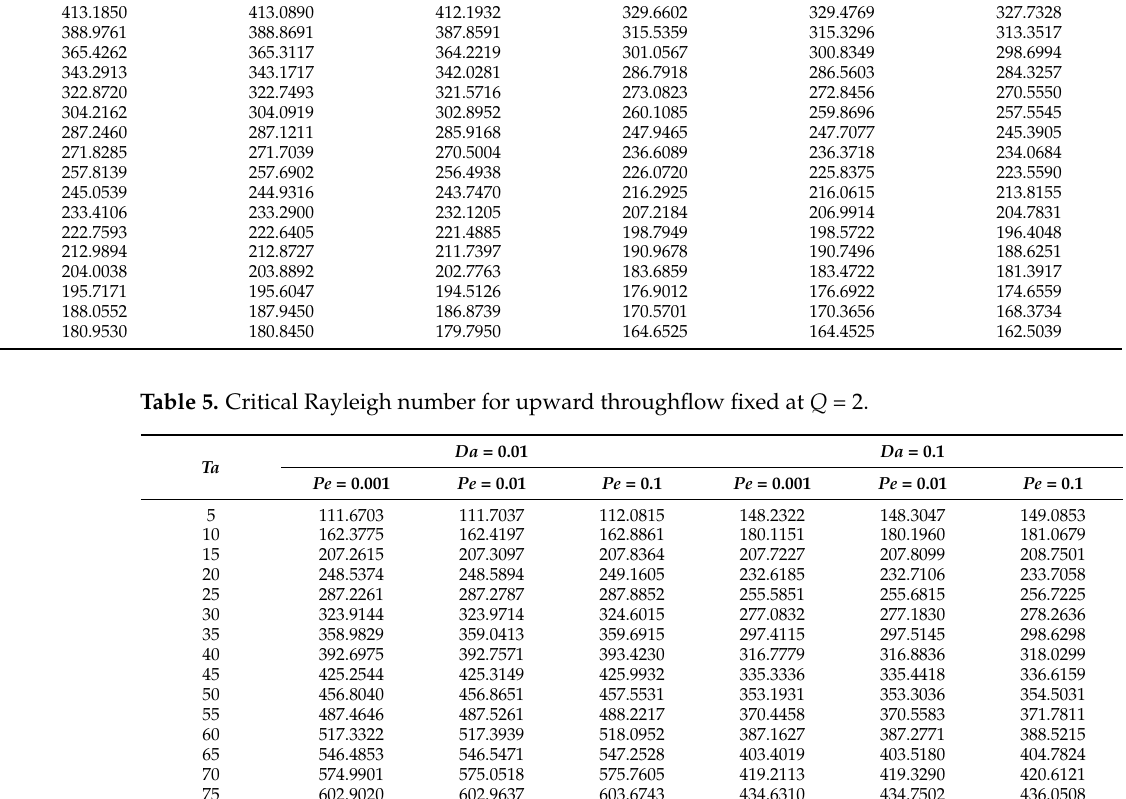
tem. Table 4. Critical Rayleigh number for downward throughflow fixed at Ta = 50.